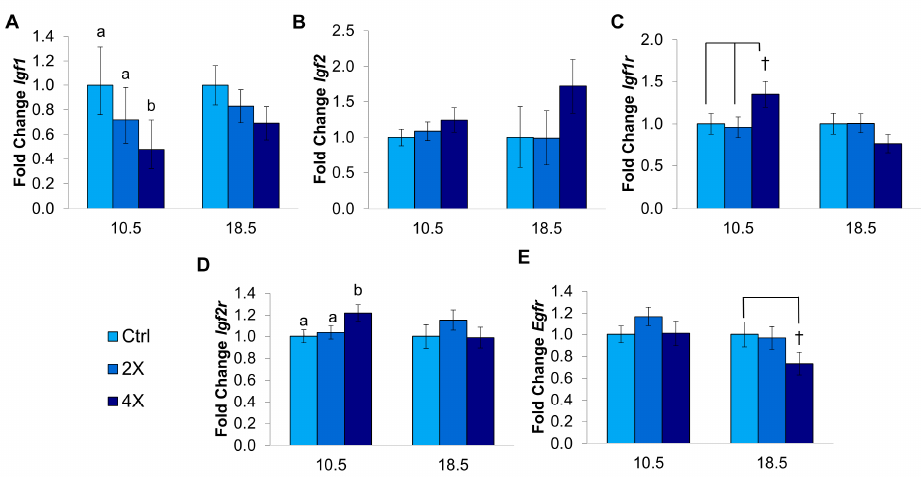
Figure 2. mRNA abundance of ( A ) Igf1 , ( B ) Igf2 , ( C ) Igf1r , ( D ) Igf2r , and ( E ) Egfr at E10.5 and E18.5 by